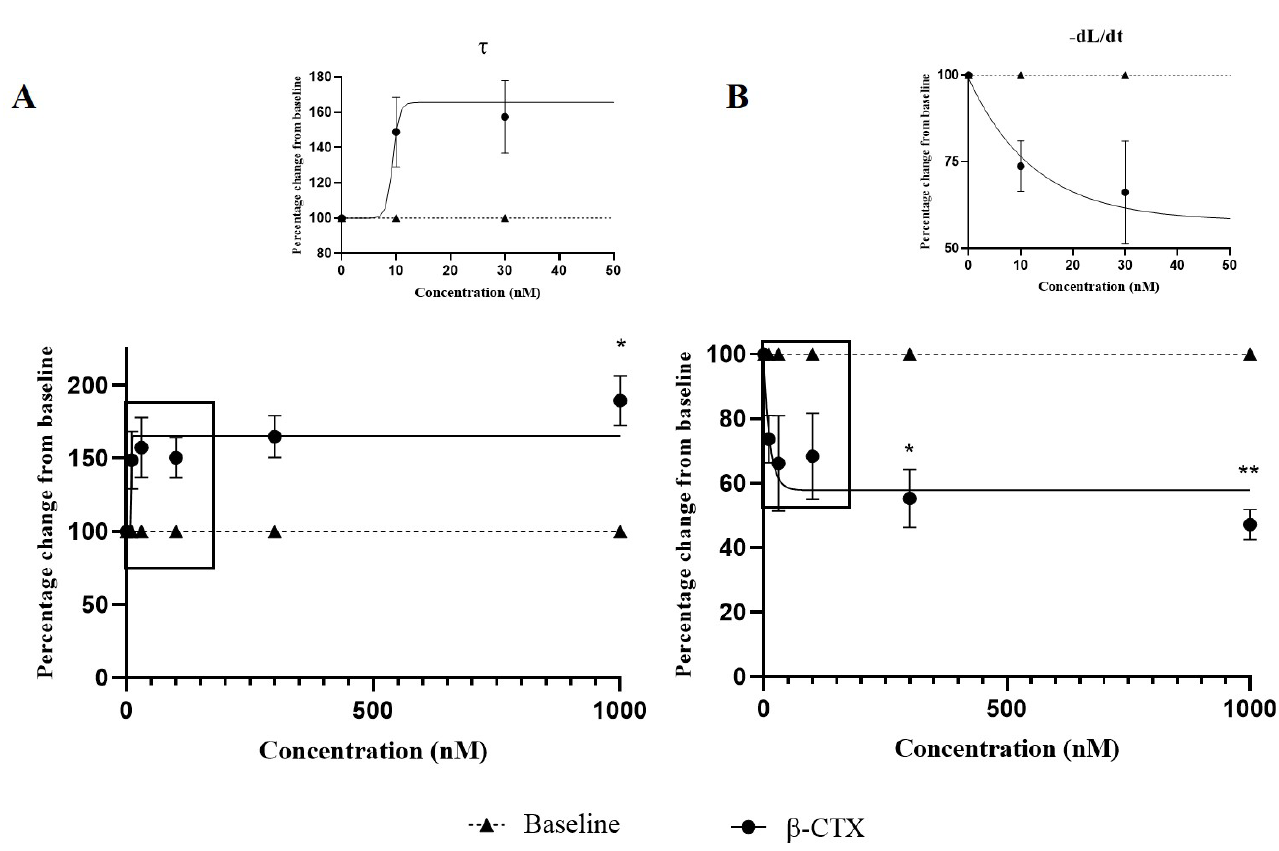
Figure 4. Effects of β-CTX on isolated cardiomyocyte lusitropy. Non-linear curve fits of (A) relaxation index (τ) and (B) re-lengthening velocity (-dL/ dt) normalized to baseline as function of toxin concentration. Insets show data at an expanded scale from the boxed area to highlight data recorded at low concentrations of β-CTX. Data are represented in mean ± S.E.M. * p < 0.05; ** p < 0.01 vs